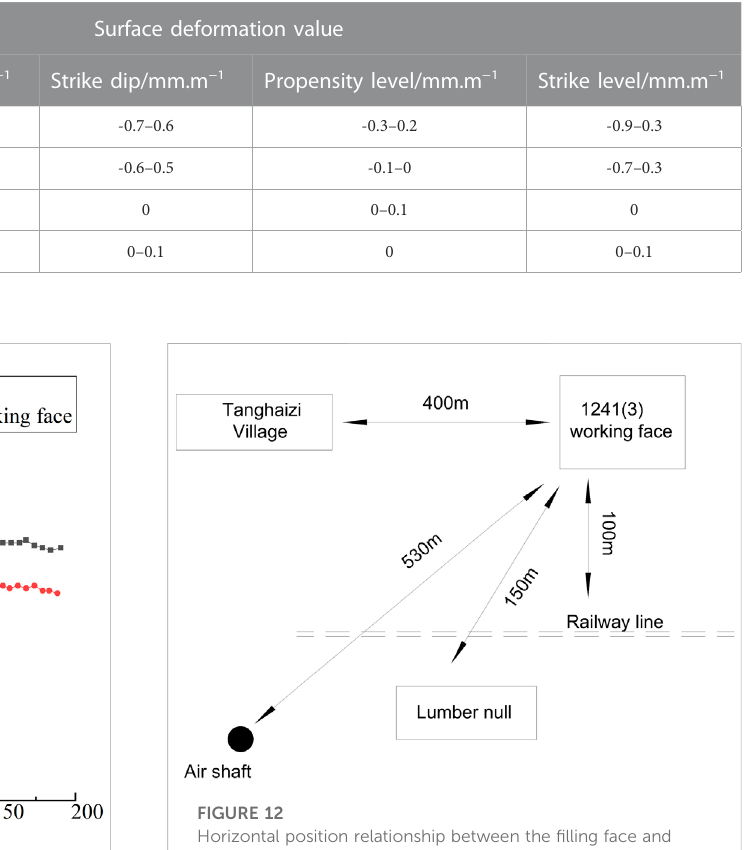
FIGURE 11 Distribution law of principal stress in the fi lling face and un fi lled face.